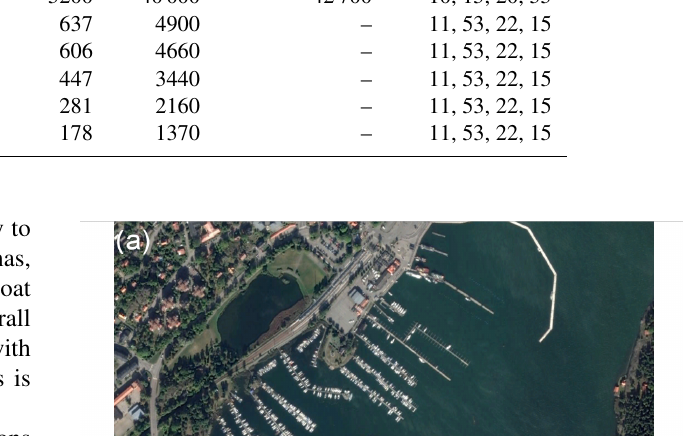
Table 5. National leisure boat counts based on survey data (Appendix A) and coastal satellite image analysis. Total modeled number of boats equals the preliminary boat count (marina) added with the estimates for boats on private shores and in trailers. The fleet composition described corresponds to the percentages used for OSB, MB, LMB and LMSB types, in the given order summing to 100%. Riparian state Boats, Boats, Boats, Total Total marina private shore offshore/trailer modeled survey Sweden